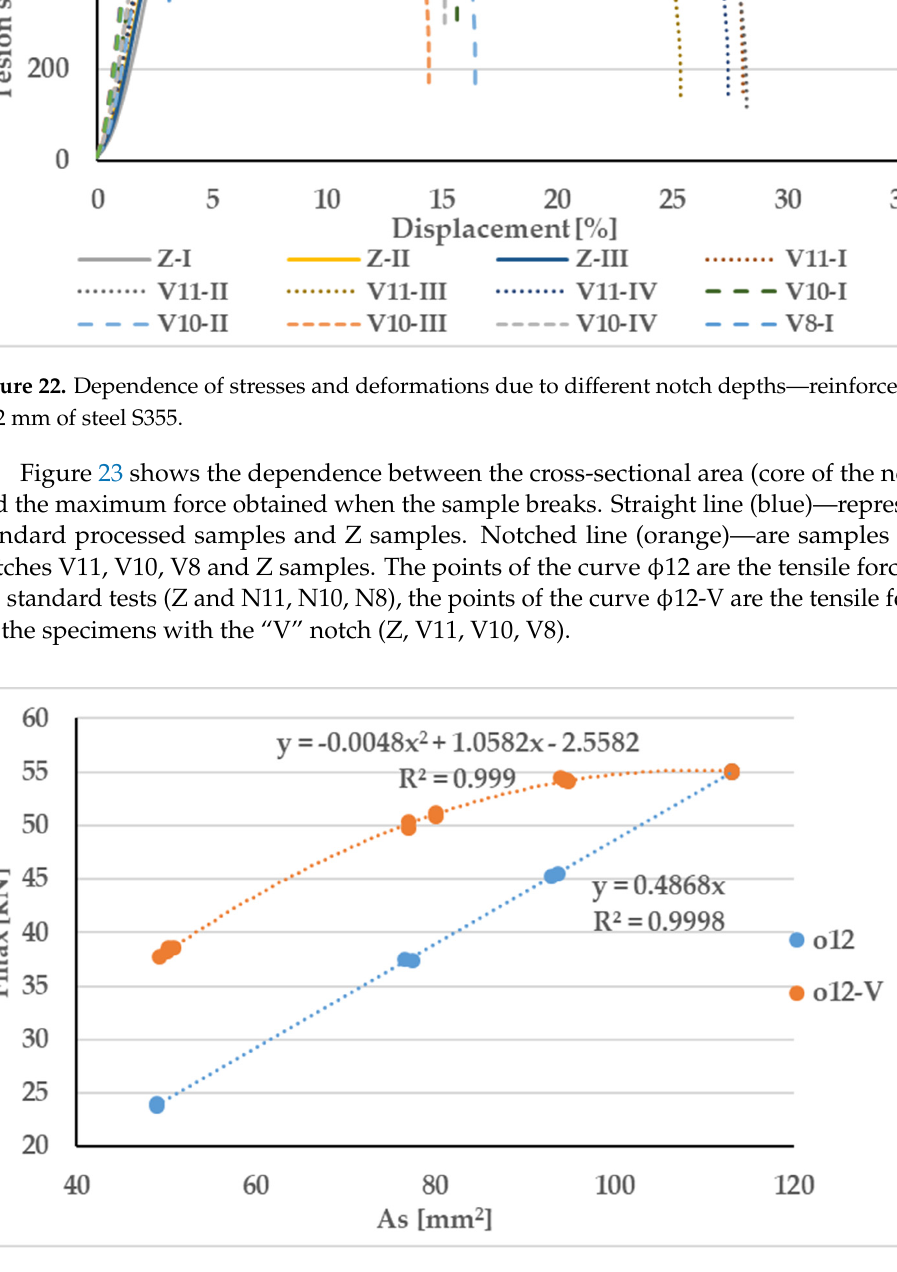
Figure 23. Dependence of the maximum force F max at failure and the corresponding cross-sectional area (core at the point of failure).